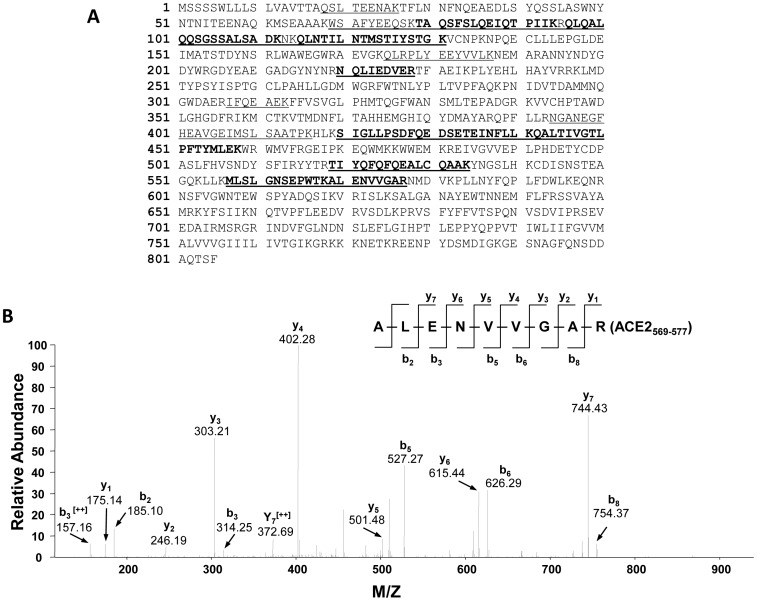
Identification of ACE2 peptides by LC-MS/MS in the 60 kDa deglycosylated band from the media of mouse PT cells.(A) Mass spectrometry identified peptides matched with the mouse ACE2 sequence (SWISS-PROT database no. Q8R0I0) at positions 18-577. The identified peptides significantly matched with mouse ACE2 sequences are underlined and shown in bold. The peptides matched with mouse ACE2 sequence, but not statistically significant, are underlined only (see Table S3 for detailed analyses of peptides). The overall sequence coverage is 24%. (B) Tandem mass spectrum of the C-terminal peptide (ALENVVGAR 569-577). The b and y ions result from the cleavage of peptide bonds and correspond to N-terminal and C-terminal fragments of the peptide, respectively. The detected b and y ions are consistent with the peptide sequence shown on the top part of the panel. Ions score: 59, Observed ion: 464.77, Mr(expt): 927.52, Mr(calc): 927.51. Expect value: 0.0002 (see Table S3 for details).